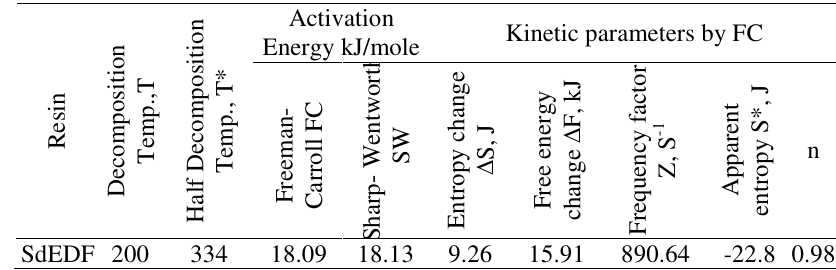
Table 2. Result of thermogravimetric analysis of SdEDF